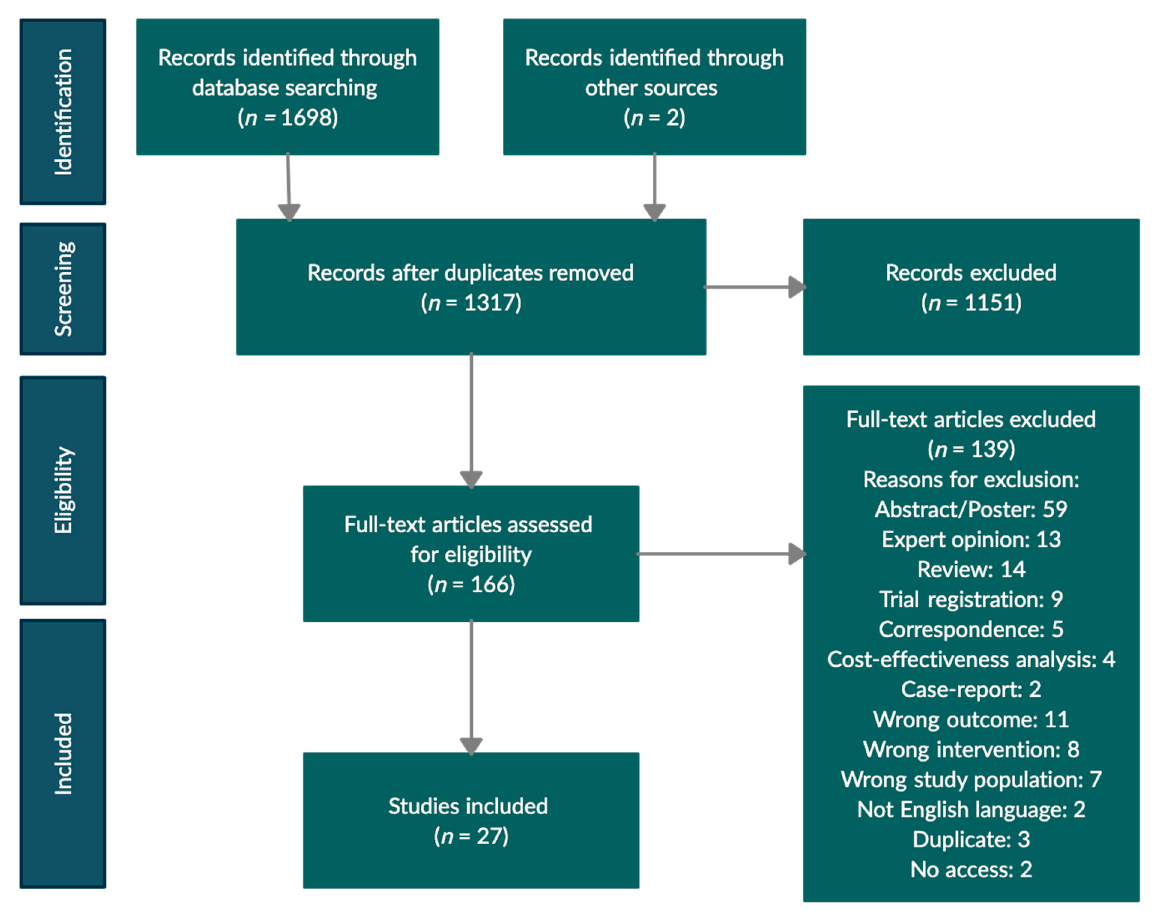
Figure 2. Flow diagram adapted from PRISMA [15].